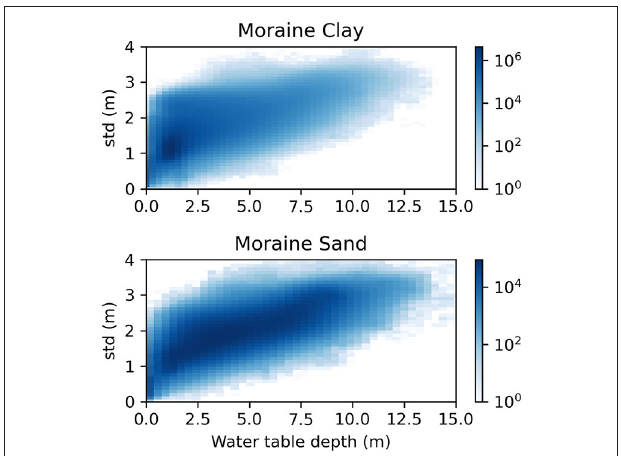
FIGURE 8 | Density scatter plot showing the simulated depth of the groundwater for moraine clay and sand soil against the associated standard deviation (std.) for the winter model. Results are shown for two of the nine soil types ( Figure 1 ).